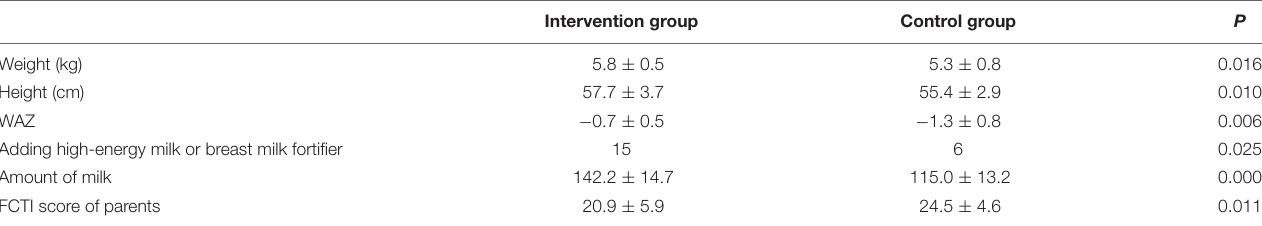
TABLE 2 | Comparison of feeding, growth and development between the two groups 3 months after discharge. Intervention group Control